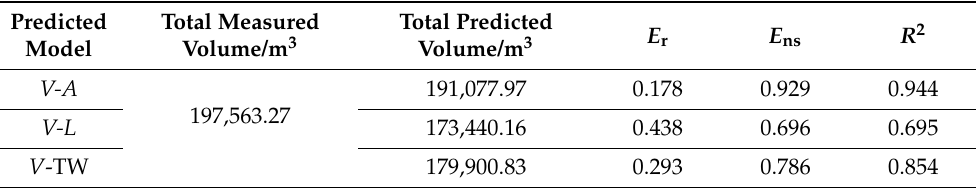
Table 3. Relative error ( E r ) and Nash–Sutcliffe efficiency ( E ns ) between measured gully volume and predicted gully volume.